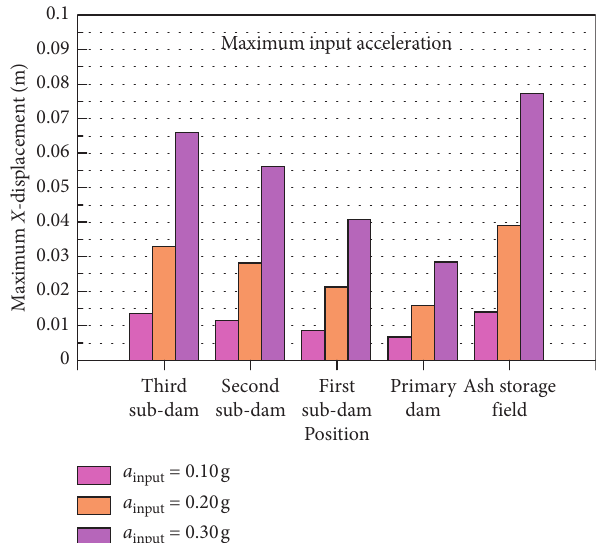
Figure 15: Peak horizontal displacement of various parts of ash storage site under three input earthquakes ( L